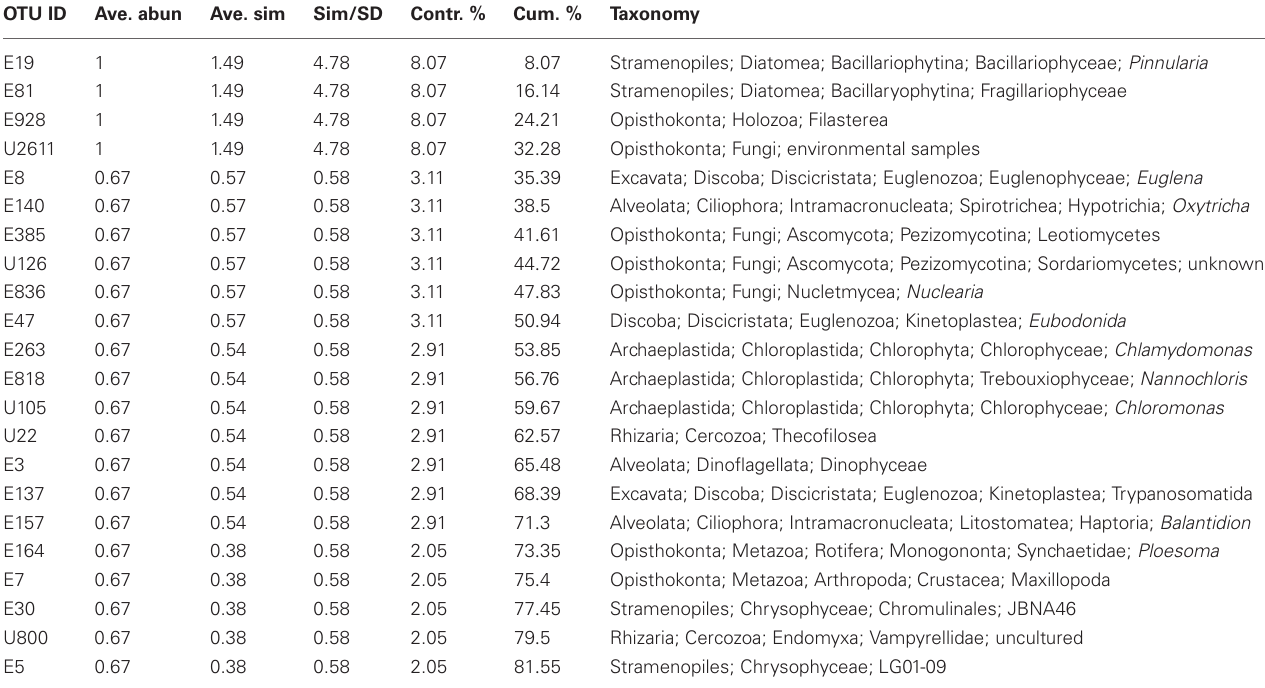
Only shown are OTUs contributing up to 80% of the cumulative (Cum.) contribution (Contr.).